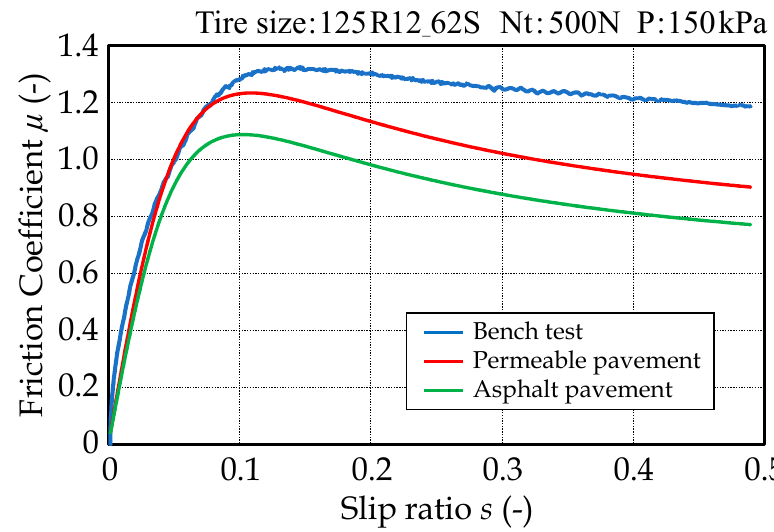
Figure 20. Comparison between bench test results and experimental results using MF.